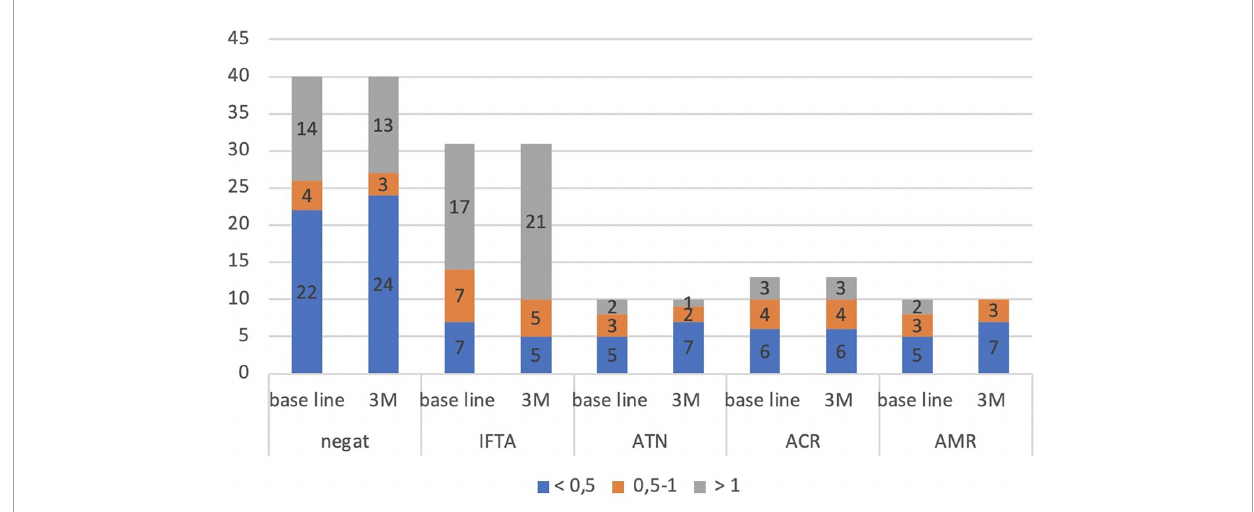
FIGURE1 Development of the A/L ratio during 3 months of follow-up in all subgroups (according to histological findings in protocol graft biopsy). IFTA, interstitial fibrosis and tubular atrophy; ATN, acute tubular necrosis; ACR, acute cellular rejection; AMR, antibody-mediated rejection; M, month.